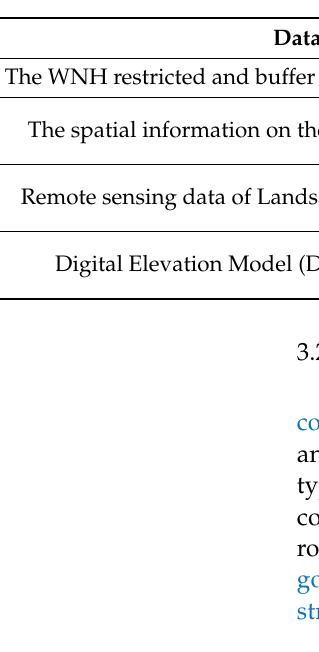
Table 1. List of data